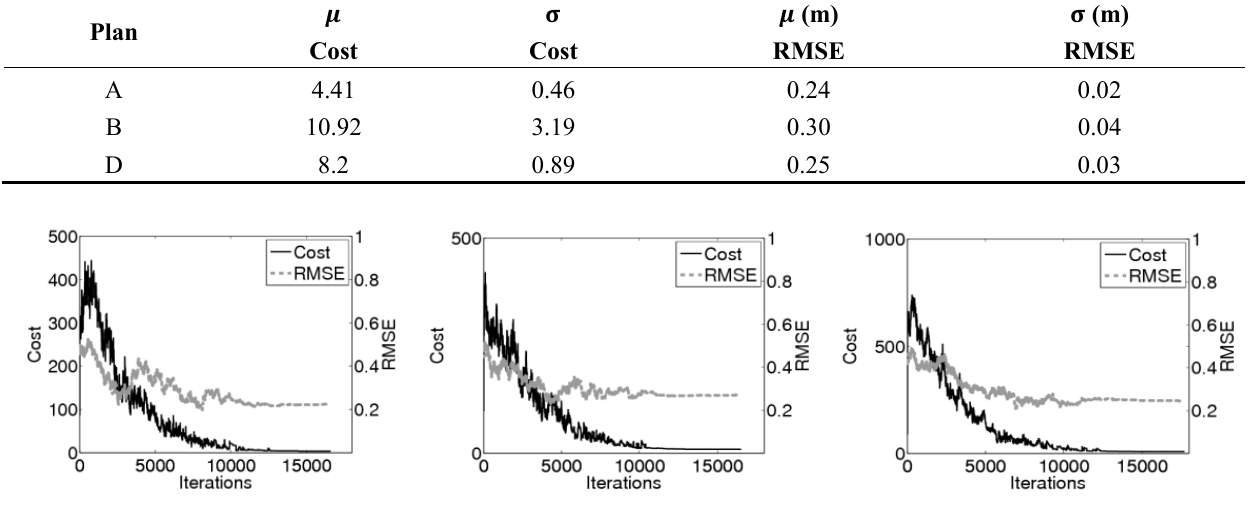
Figure 10. Example optimisation runs for plans A ( left ), B ( centre ) and D ( right ) showing cost and RMSE vs. iteration